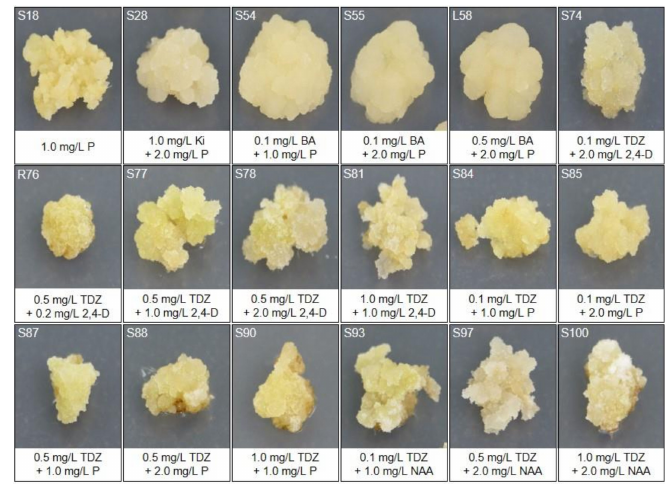
Figure 2. Variations in callus color and morphology under di ff erent culture conditions after 8 weeks of cultures. Conditions for each numbered callus are presented under the photographs. P, picloram; Ki, kinetin; BA, 6-benzyladenine; TDZ, thidiazuron; 2,4-D, 2,4-dichlorophenoxyacetic